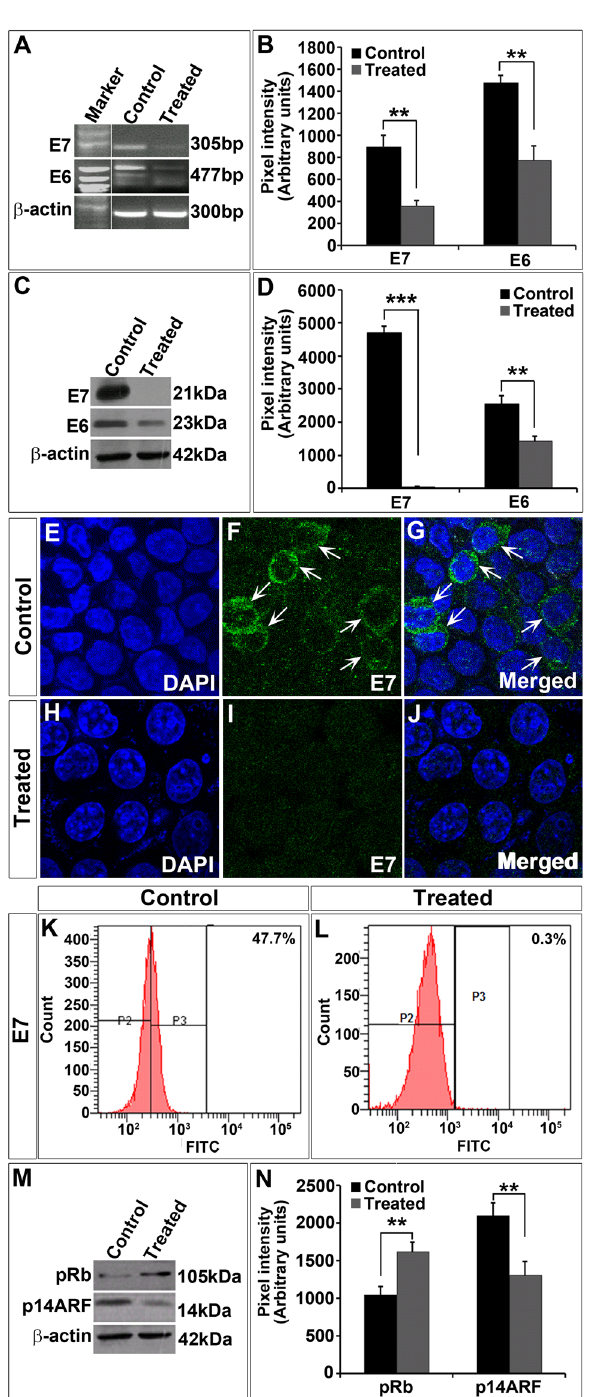
Figure 3. TALEN-mediated E7 editing reduced E7 gene expression in SiHa cells. ( A ) RT-PCR analysis for the transcripts corresponding to E7 and E6 showed a significant reduction in treated (TALEN-transfected) group when compared to controls. ( B ) Graph represents expression levels of E7 and E6 in control and treated groups. RT-PCR data was further corroborated by western blot analysis which showed a significant reduction in the levels of both E7 and E6 after TALEN treatment ( C ). Graph depicts the densitometric analysis of western blots of E7 and E6 against β -actin protein levels ( D ). Immunocytochemical analysis also indicated that E7 protein levels were significantly decreased in TALEN-treated SiHa cells ( H – J ) when compared to controls ( E – G ). Further, analysis of E7 expressing cells by flow cytometry also revealed a decrease in the percentage E7 expressing cells in TALEN-treated group ( L ) than in controls ( K ). Western blot analysis of pRb and p14ARF suggested that the levels of pRb were increased and that of p14ARF was reduced in TALEN-treated cells when compared to controls ( M ). The densitometric analysis of the western blots was given in graph ( N ). Data are expressed as mean ± SD from triplicates of three different experiments. ** P < 0.001, *** P <